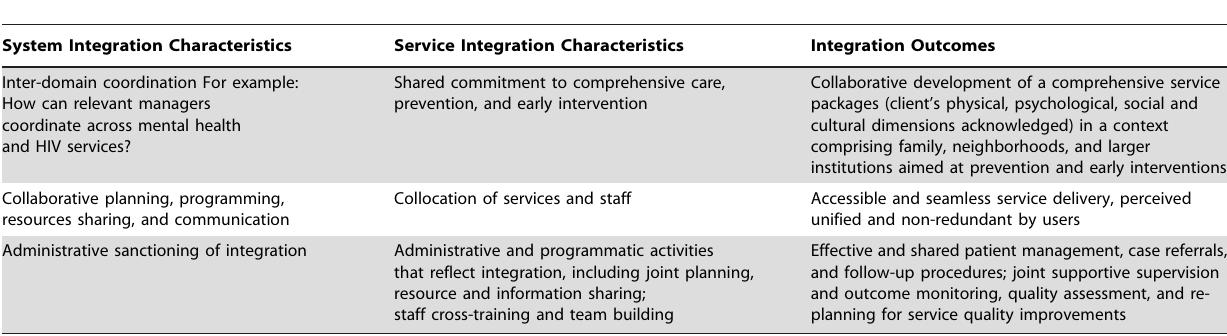
Table 2. Integrating Mental Health Services into Primary HIV Care For Women: The Whole Life